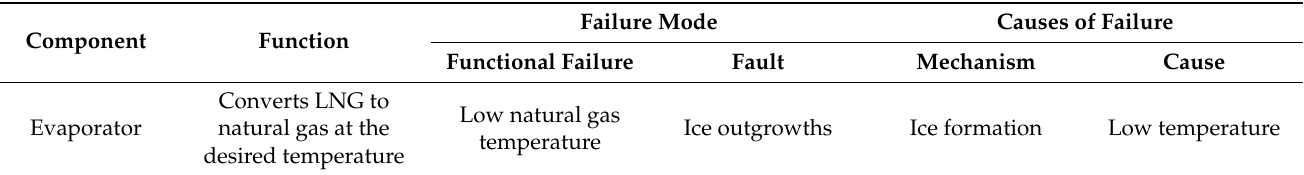
Table 1. Failure Modes, Effects, and Criticality Analysis (FMECA) typical structure (example of the LNG evaporator). Component